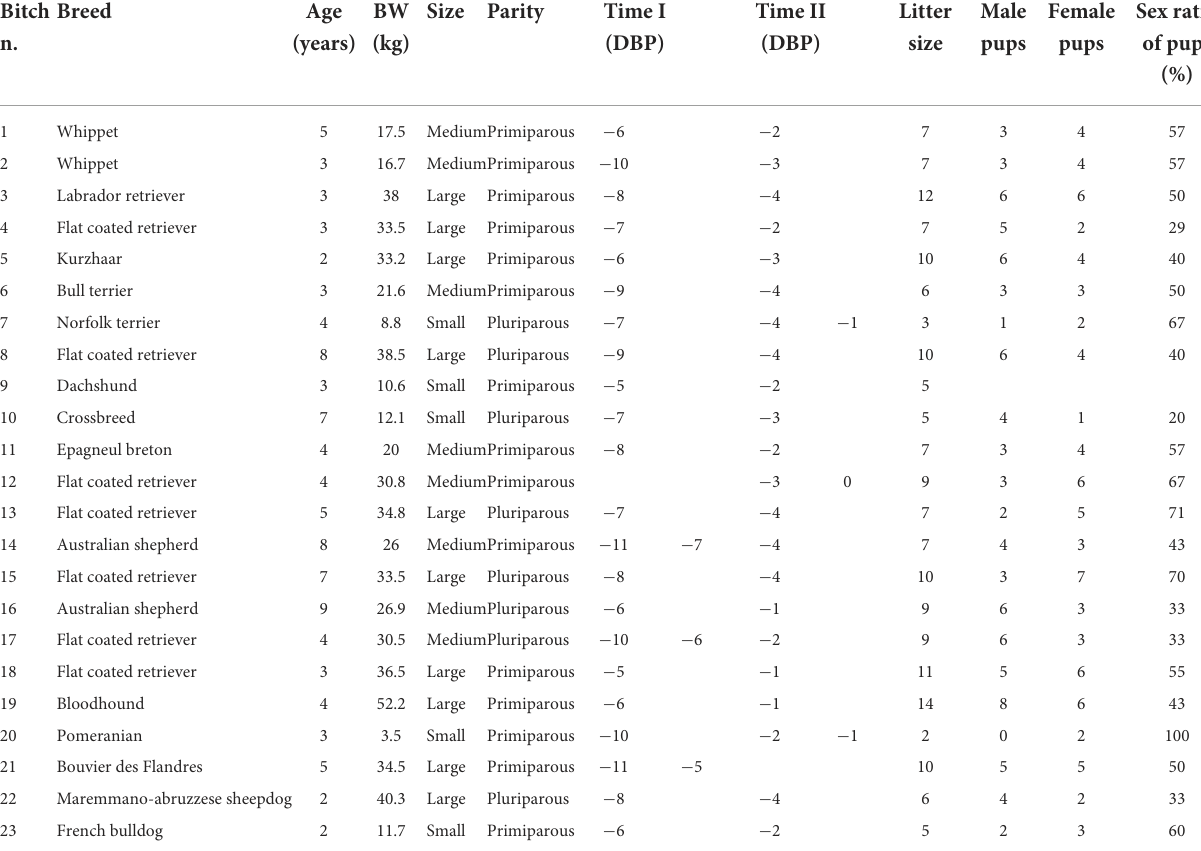
TABLE 1 Bitch identification number (n.), breed, age, body weight (BW), maternal size, parity, litter size, number of male and female pups, the sex ratio of pups, and days of consultation (day 0 = day of parturition) of bitches included in the study. Bitch n.